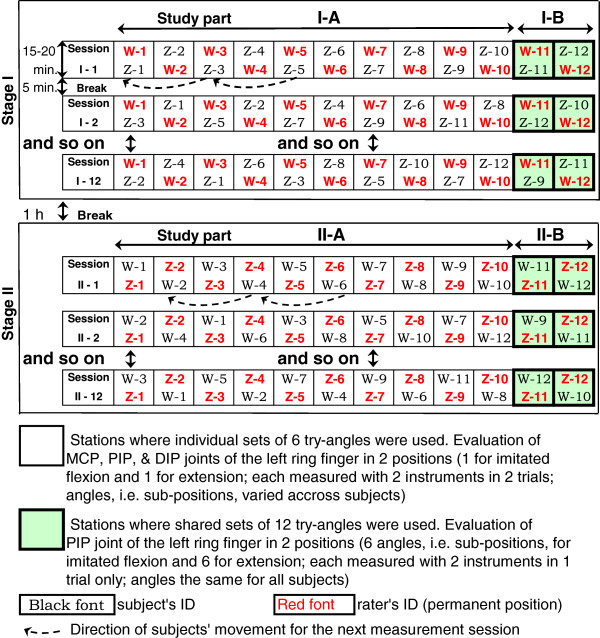
Scheme of the study.